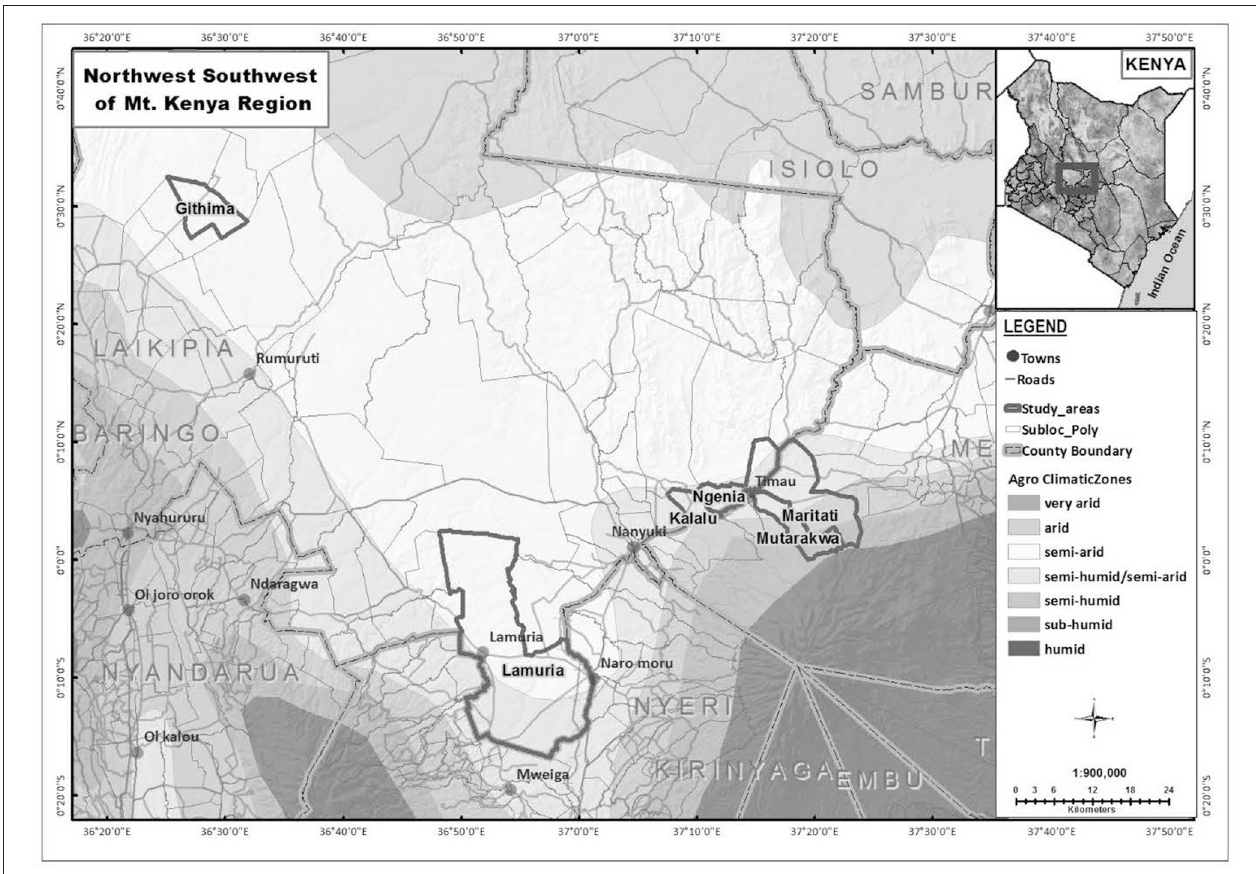
FIGURE 1 | Study area in the North-Western Mount Kenya